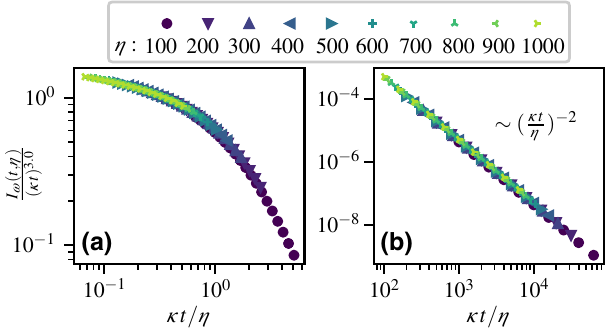
FIG. 3. Finite-size scaling of the global QFI of the critical open Rabi model plus the environment, in both (a) the tran- sient regime κ t (cid:2) η and (b) the long-time regime κ t (cid:10) η . The open system is at a dissipative critical point g = g CP , and η is its effective size (see the text). Parameters: κ = 0.1, ω =